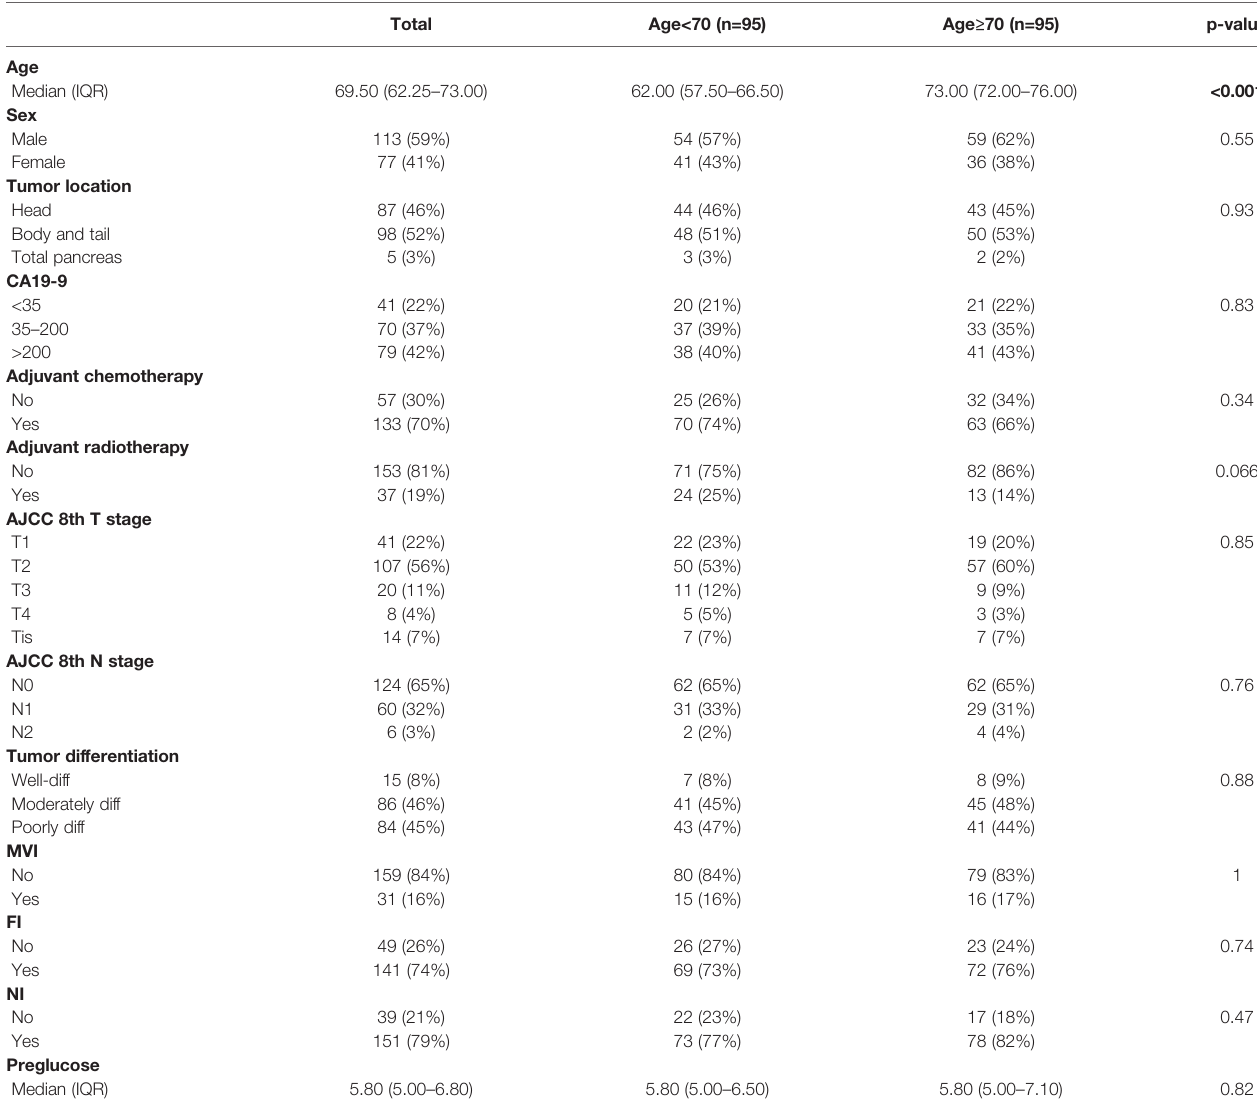
TABLE 2 | Baseline characteristics of the study population after PSM